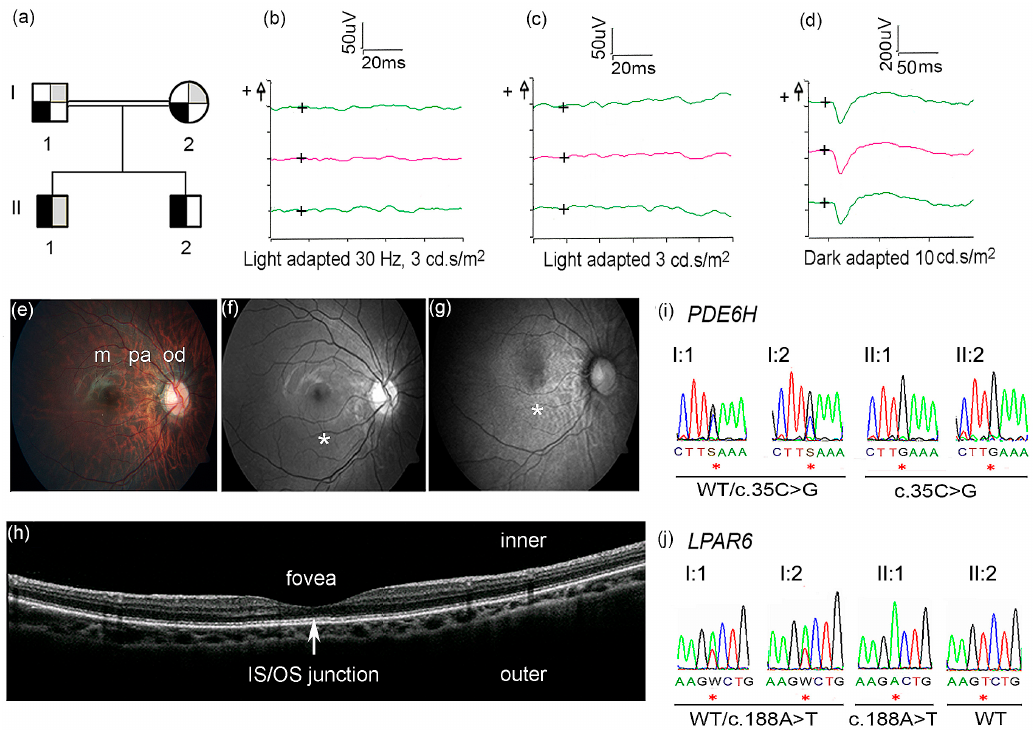
Figure 1. ( a ) Family pedigree showing segregation of incomplete achromatopsia (IA) and alopecia. Black symbol refers to IA, grey symbol refers to alopecia; ¼ filled symbols = carrier, ½ filled symbols = affected. The genotype of the PDE6H and LPAR6 are the following: I:1 WT/c.35C>G;